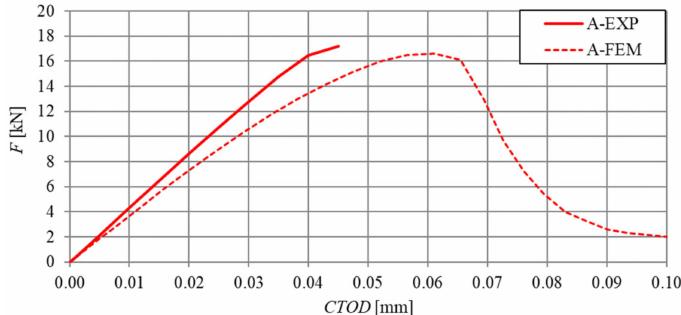
Figure21. Comparisonofnumericalandexperimentalforce-cracktipopeningdisplacementrelationship of HSC beams in three-point bending tests (series A).